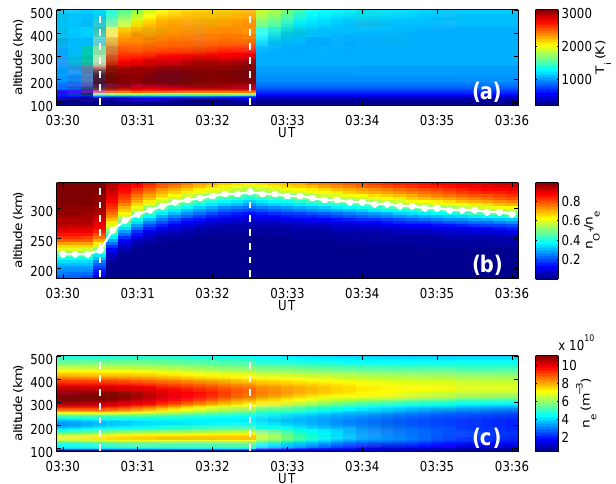
Fig. 4. TRANSCAR simulations of the temporal features of iono- spheric response to a 75mVm − 1 effective electric field. The begin- ning and end times of the electric field disturbance are marked by dashed lines in all panels. Panel (a) ion temperature vs. altitude and time. Panel (b) ion composition shown as the fraction of the plasma that is O + . The altitude at which the plasma is 50% O + is marked by a solid line. Panel (c) plasma density vs. altitude and